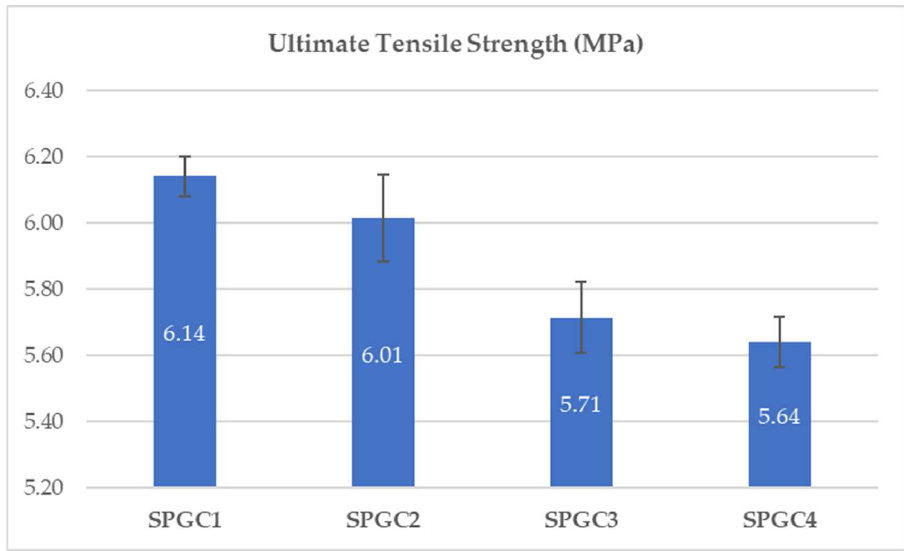
Figure 1. The effects of citric acid on the mechanical properties of biodegradable starch-based films [citric acid concentrations (0.46, 0.92, 1.38, and 1.83 wt%)].